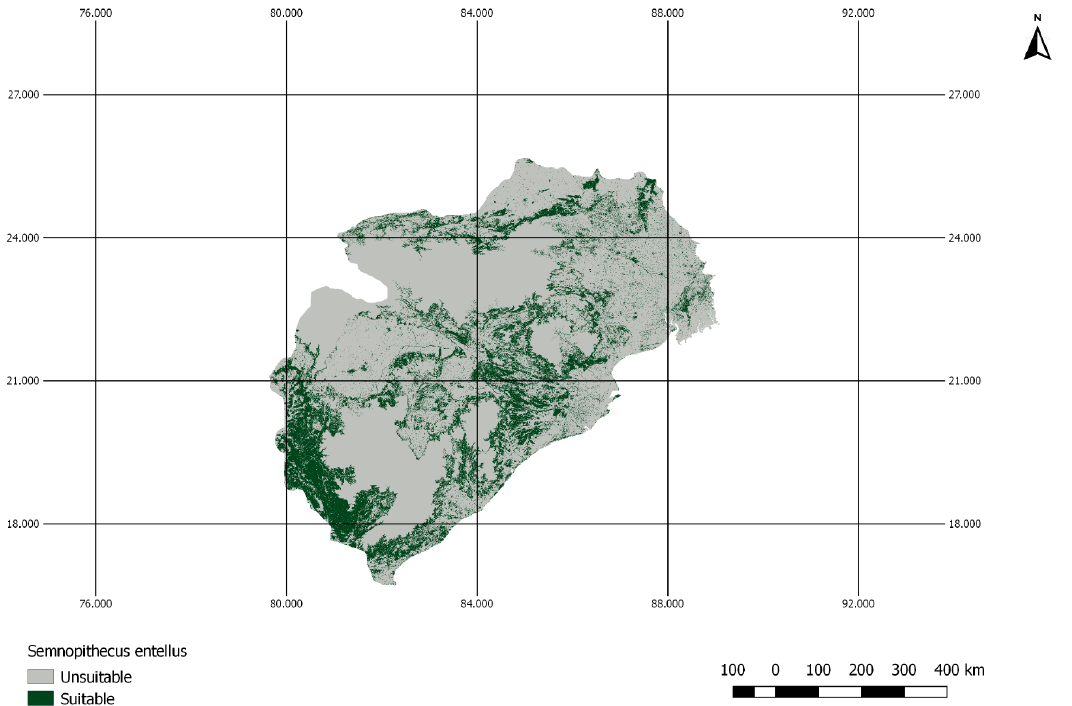
Figure A3. AOH for the species Semnopithecus entellus . There is a large proportion of land cover class “cropland” inside the range map of this species. However, this species is not coded to habitats that are associated with the land cover “cropland”. Therefore, the model prevalence is lower than estimated.